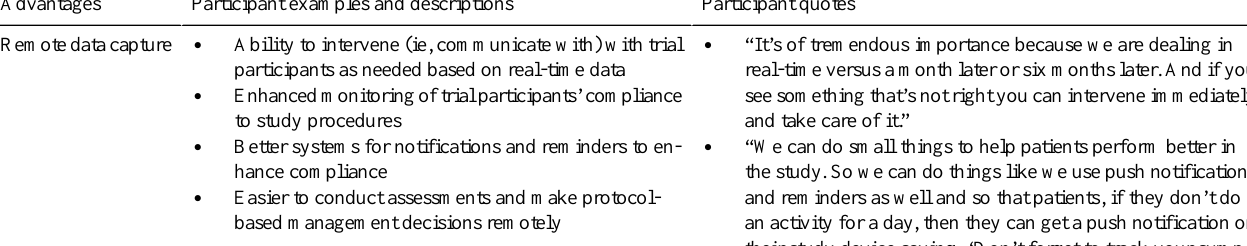
Participant quotesParticipant examples and descriptionsAdvantages